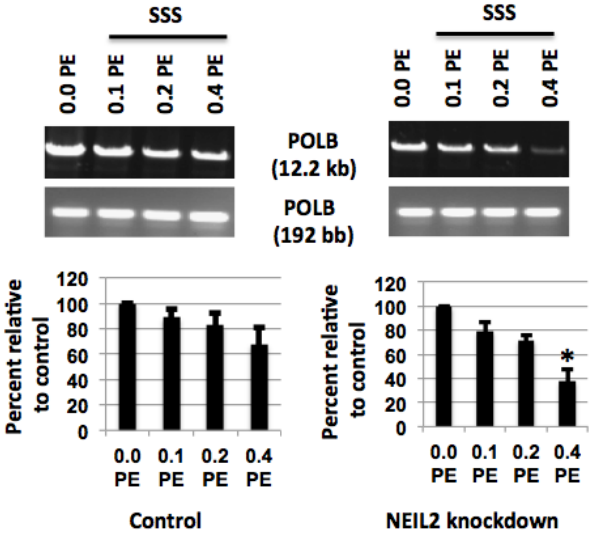
Figure 5. Effect of NEIL2 knockdown on induction of oxidative DNA damage by exposure to SSS for 24h in the human POLB gene using LA-QPCR. (A) Cultured primary hPF with NEIL2 knockdown were treated with 3 doses of SSS extract as compared to the control on the left, followed by processing of the DNA with Fpg and Nei. The DNA was used for Pol b ( POLB ) large and short fragment amplification by LA-QPCR. Quantification was with ImageQuant (Molecular Dynamics). The histogram depicts the mean % of DNA tail 6 SEM of 3 to 4 independent experiments. The symbol * means that the differences between the Control and NEIL2 knockdown were statistically significant (P , 0.05).